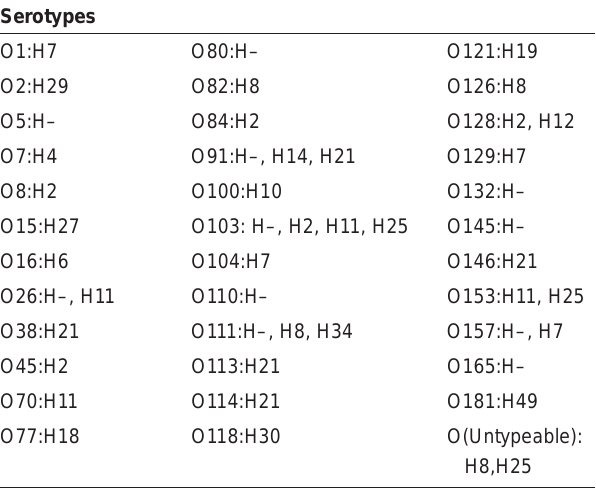
TABLE 3 Verotoxigenic Escherichia coli (VTEC) serotypes isolated from human sources in Canada between